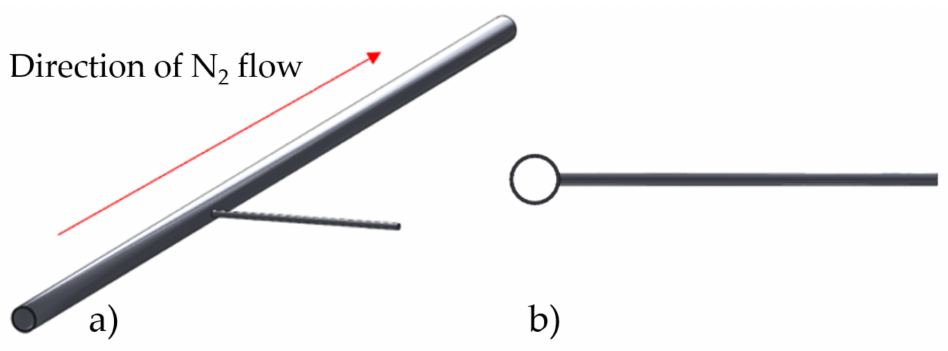
Figure 2. Basic geometry model. ( a ) Isometric view and ( b ) rear view.